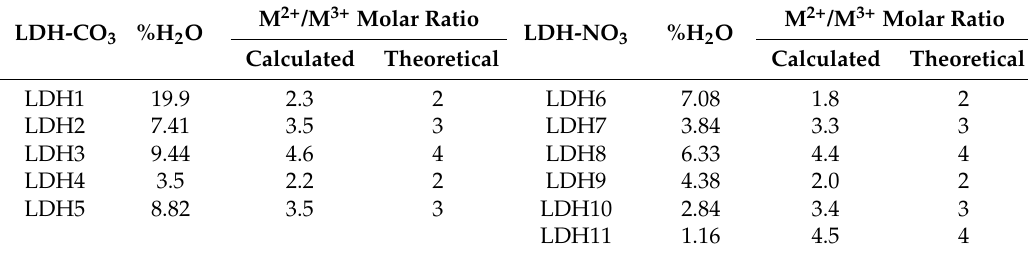
Table 3. Percentage (%) of H 2 O loss from LDHs and comparison of the theoretical and calculated M 2+ /M 3+ ratios.